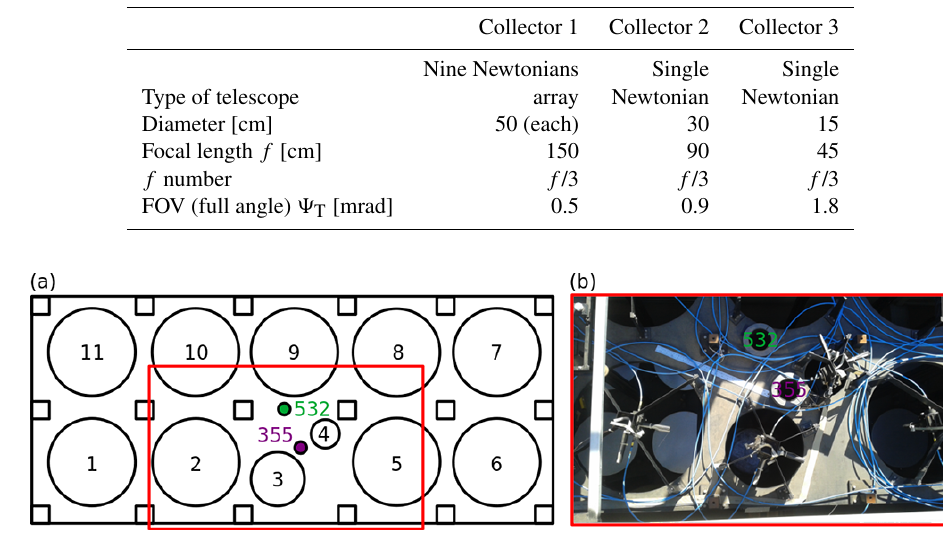
Table 2. Telescope characteristics.